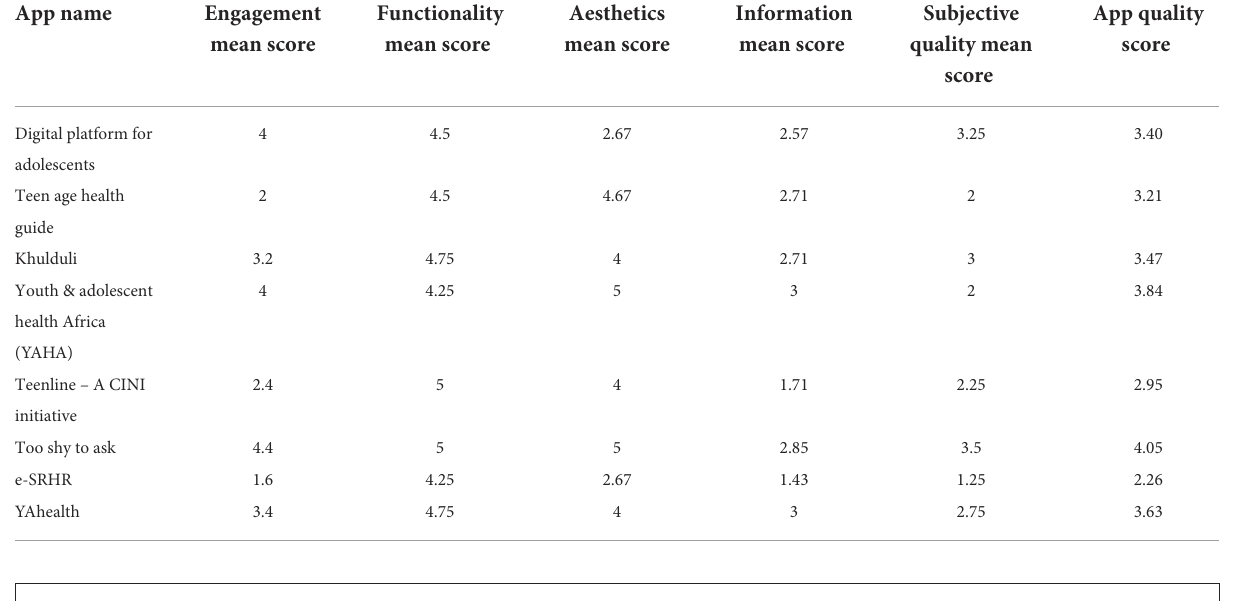
TABLE 1 MARS subdomain scores and overall app quality scores.